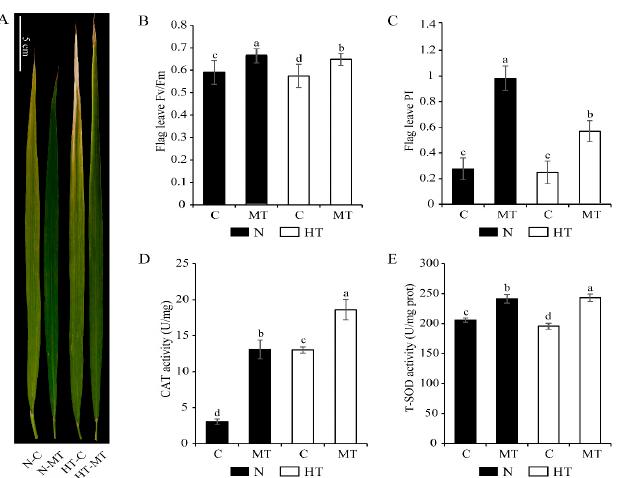
Figure 1. Photosynthetic indexes of NPB plants treated with melatonin at different temperatures. ( A ) Photographic observation of NPB rice leaves. ( B ) and ( C ) Determination of Fv/Fm and PI values of flag leaves of NPB. ( D ) and ( E ) Determination of CAT and T-SOD activities of NPB leaves. The data presented in the figure are repeated through three independent experiments, values with dif- ferent letters (a, b, c and d) in the same column are significantly different at p < 0.05, calculated by one-way ANOVA. “N” and “HT” indicate normal and high temperature conditions. “C” and “MT” indicate H 2 O and melatonin treatment, respectively.